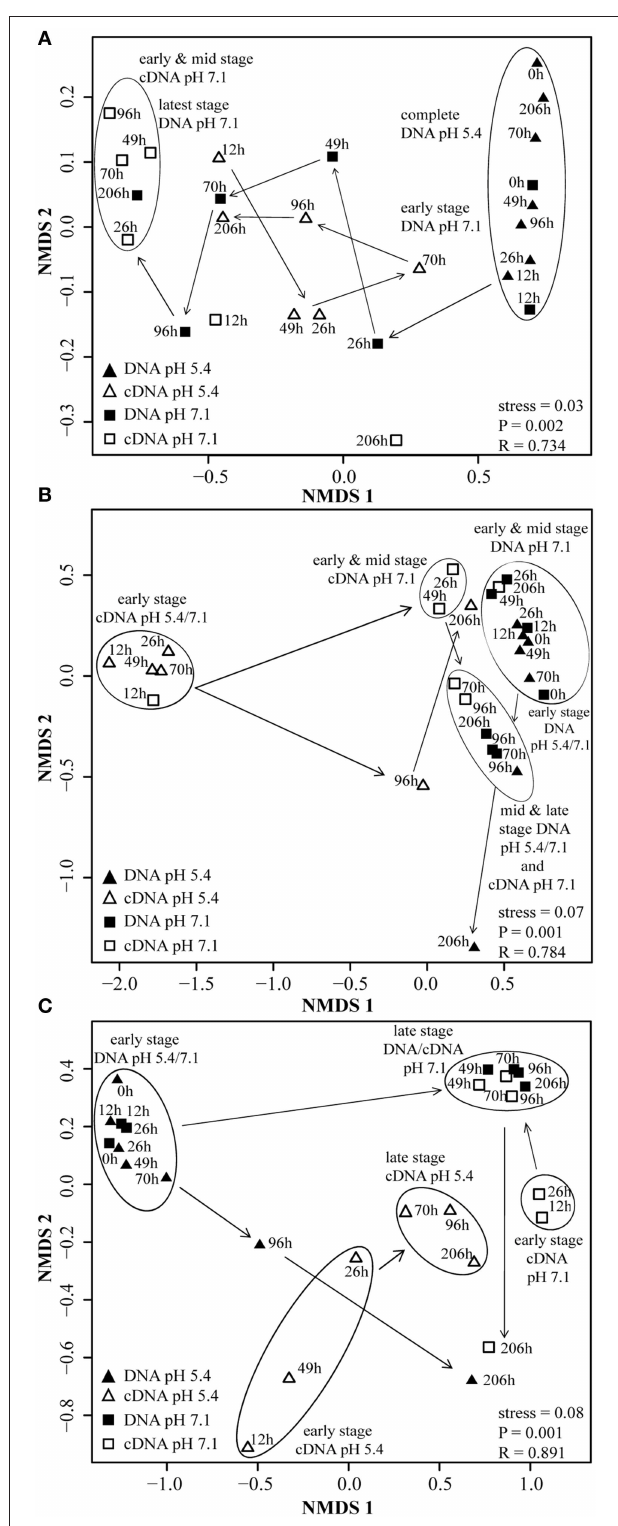
FIGURE 5 | NMDS plots of denitrifier communities based on cDNA- and DNA-derived T-RFLP analysis of nirK , nirS , and nosZ from three pooled samples. Data points represent averaged results of three replicate